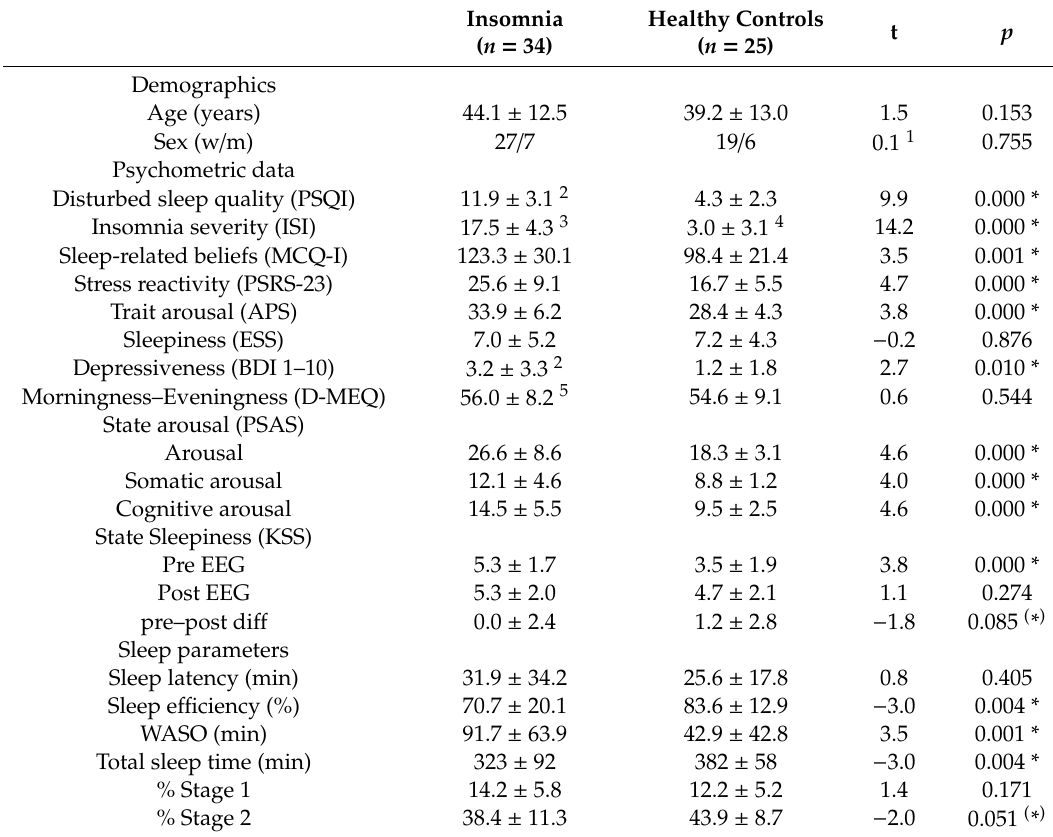
Table 1. Demographic and psychometric characteristics and polysomnographic sleep